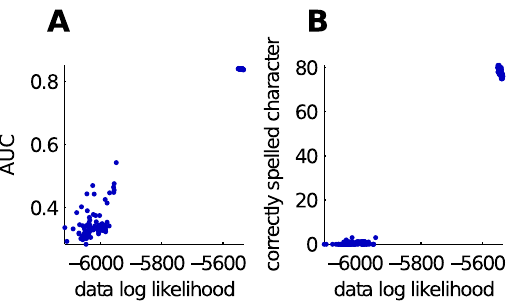
Figure 4. Scatter plots showing the quality of the classifier. Quality is measured in either AUC or characters predicted correctly versus the data log likelihood. The data used in this plot is created in the OFF-US experiment on subject B using 5 repetitions.